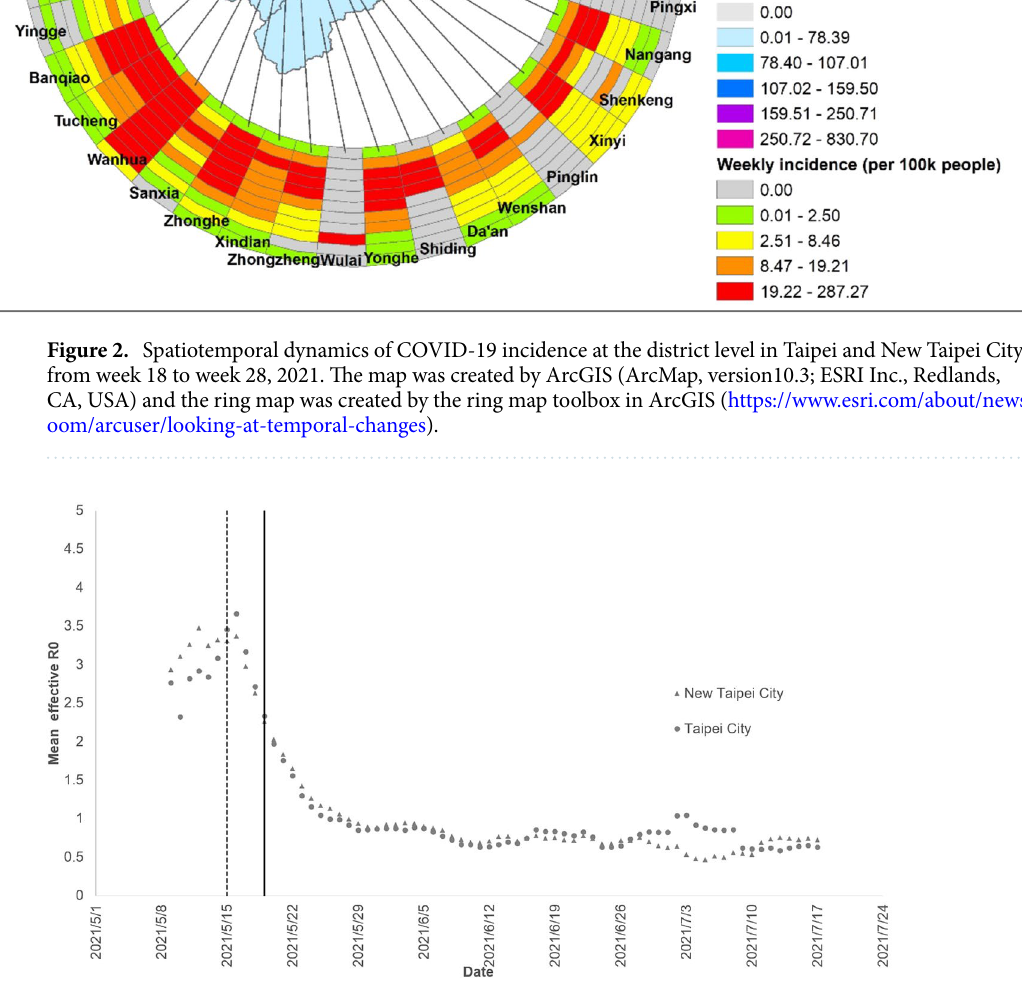
Figure 3. Daily mean effective reproduction number in Taipei and New Taipei City. The left vertical dashed line is the level three alert in Taipei and New Taipei City on May 15, 2021. The right vertical solid line is the level three alert throughout Taiwan on May 19,